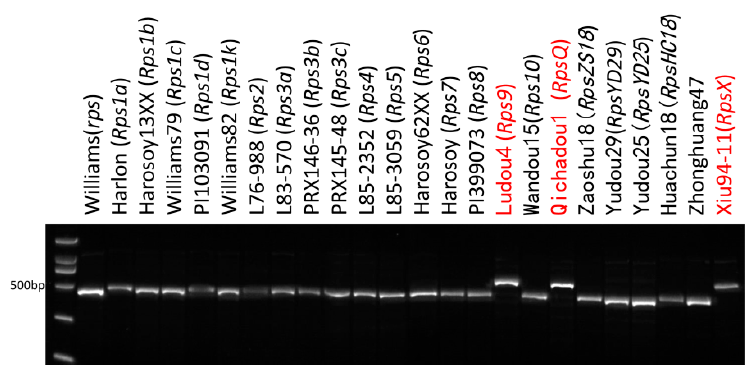
Figure 7. Molecular banding patterns for PRR-resistant cultivars containing the identified Rps genes. The cultivars were analyzed with the Insert144 marker developed based on the 144-bp insertion in RpsX and RpsQ .